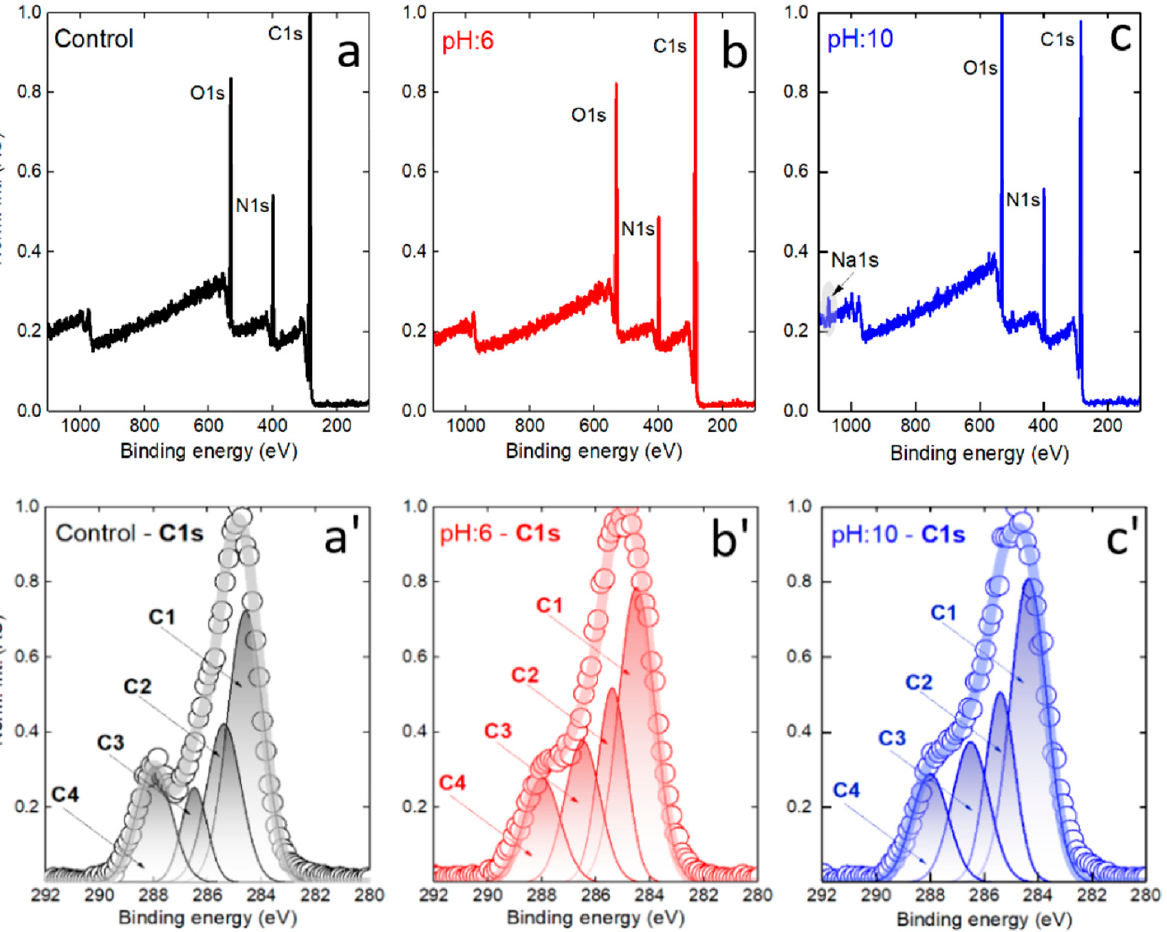
Figure 8. XPS survey spectra for control silk ( a ), dyed silk after interaction with acidic media ‘pH:6 ( b ) and alkaline environment ( c ). Gaussian fits of the corresponding C1s core level peak ( a’ – c’ ).